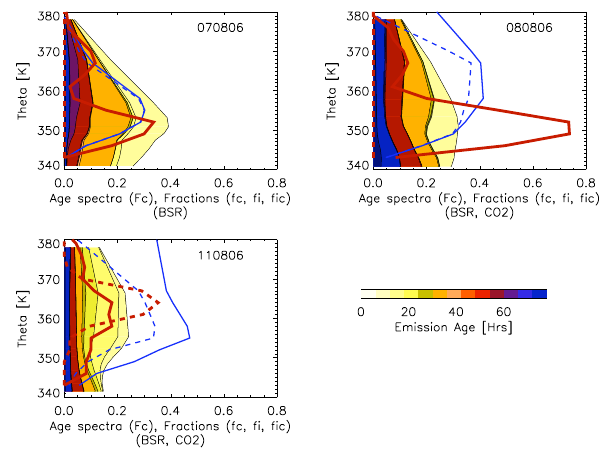
Fig. 10. Vertical profiles of the diagnostics described in the text. Model-derived ones are plotted in blue, observation-derived in red. Left column: BOLAM ice fraction f i (solid blue line) and convec- tive ice fraction f ic (dashed blue line); observed aerosol fraction f BSR (dotted red line), Right column: convective fraction f c ; ob- served fraction of outliars in CO 2 f CO plotted as dashed red line; 2 f BSR is also plotted to be compared with f c . Top panels are for 7 August, middle for 8 August and bottom for 11